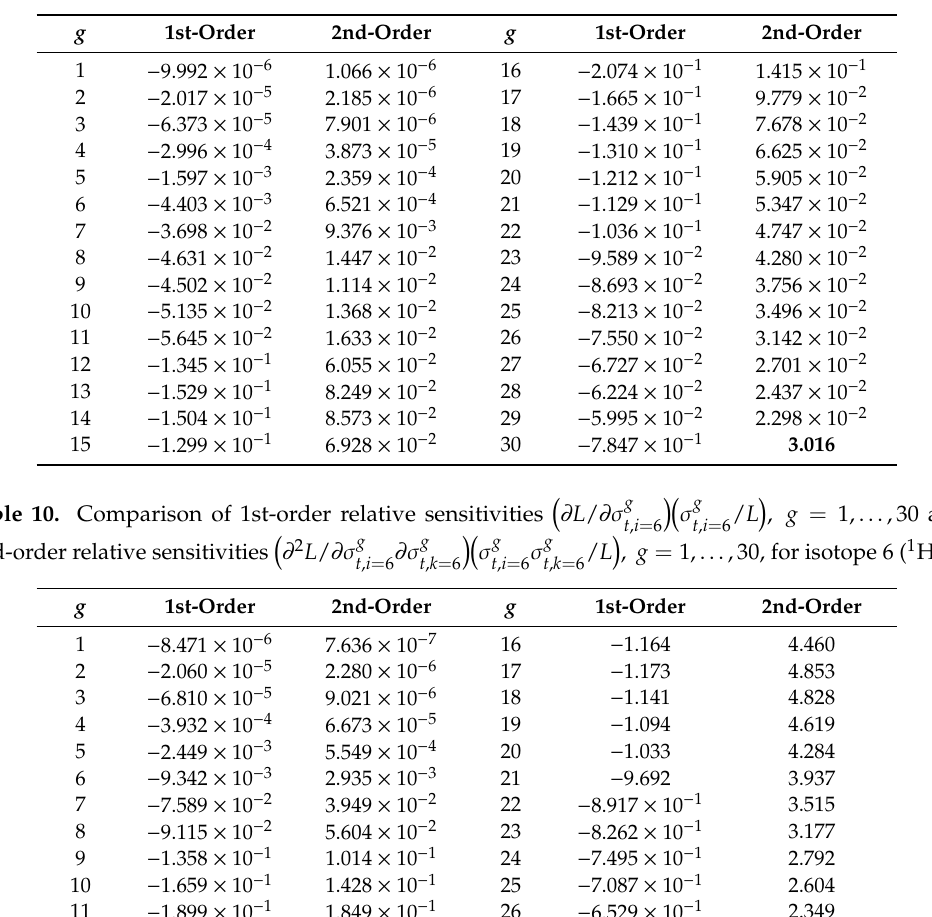
Table 9. Comparison of 1st-order relative sensitivities and 2nd-order relative sensitivities 5 (C).